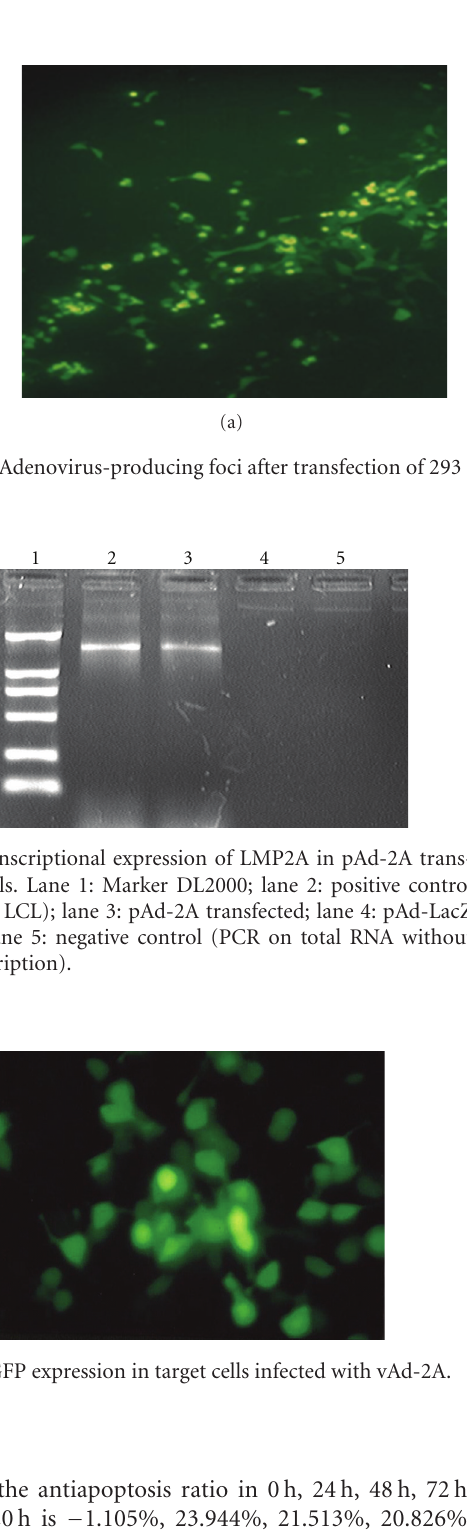
time point, the antiapoptosis ratio in 0 h, 24 h, 48 h, 72 h, 96 h, and 120 h is − 1.105%, 23.944%, 21.513%, 20.826%, 24.874%, and 16.029%, respectively, as shown in Table 1. vAd infected SGC cells had no significant change.